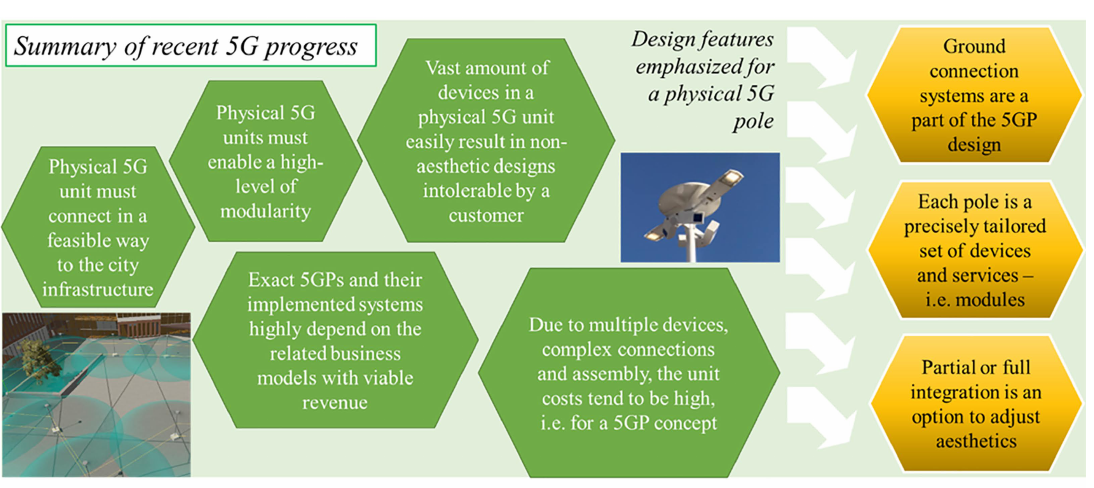
Figure 1. Summary of the design drivers for a physical platform for various wireless